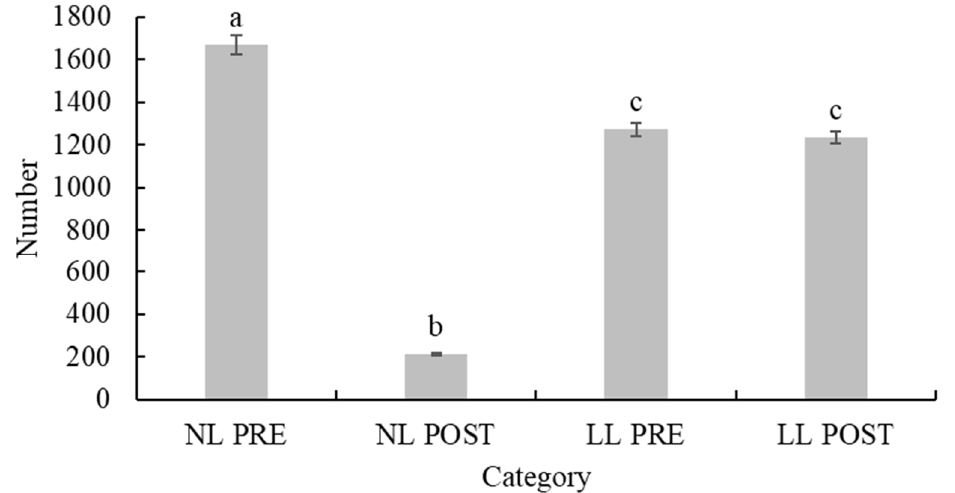
Figure 1. The number of juvenile European hedgehogs admitted to wildlife rehabilitation centres in the Czech Republic in the years 2011 to 2020, total 4388, divided into four categories by weight and timing of litter. Columns or bars with different letters (i.e., a versus b, a versus c, b versus c) indicate that they are statistically different from each other, while those with same letters (c versus c) indicate that they are not statistically different from each other. NL PRE = pre-weaned juvenile hedgehogs from normally timed litters; NL POST = post-weaned juvenile hedgehogs from normally timed litters; LL PRE = pre-weaned juvenile hedgehogs from late litters; LL POST = post-weaned juvenile hedgehogs from late litters.